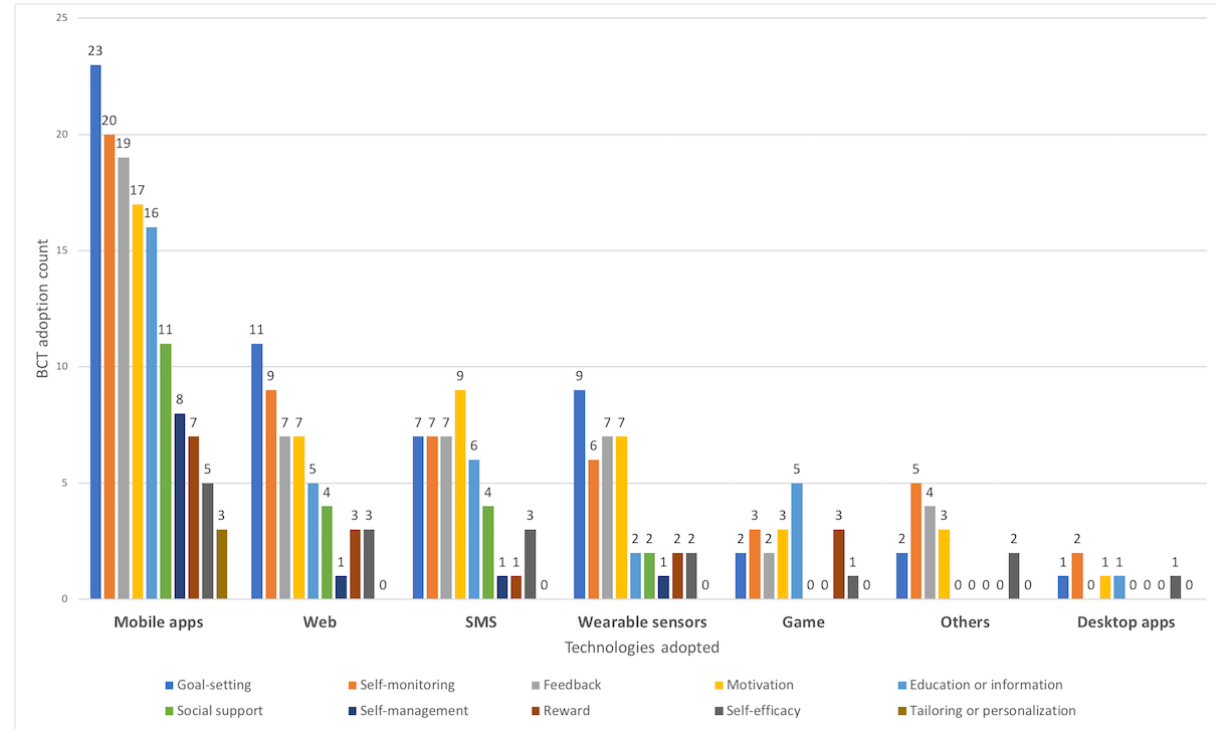
Figure 11. Frequency of different behavior change techniques per technological